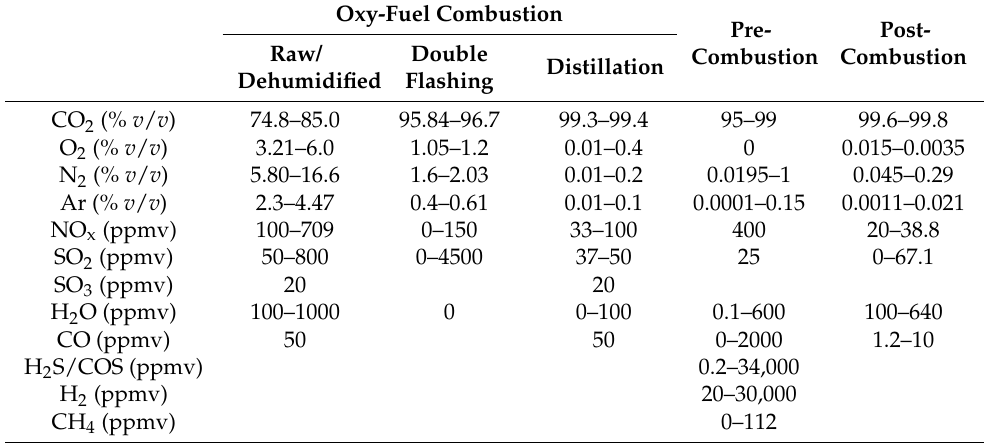
Table 4. Summary of CO 2 impurities from different CO 2 capture